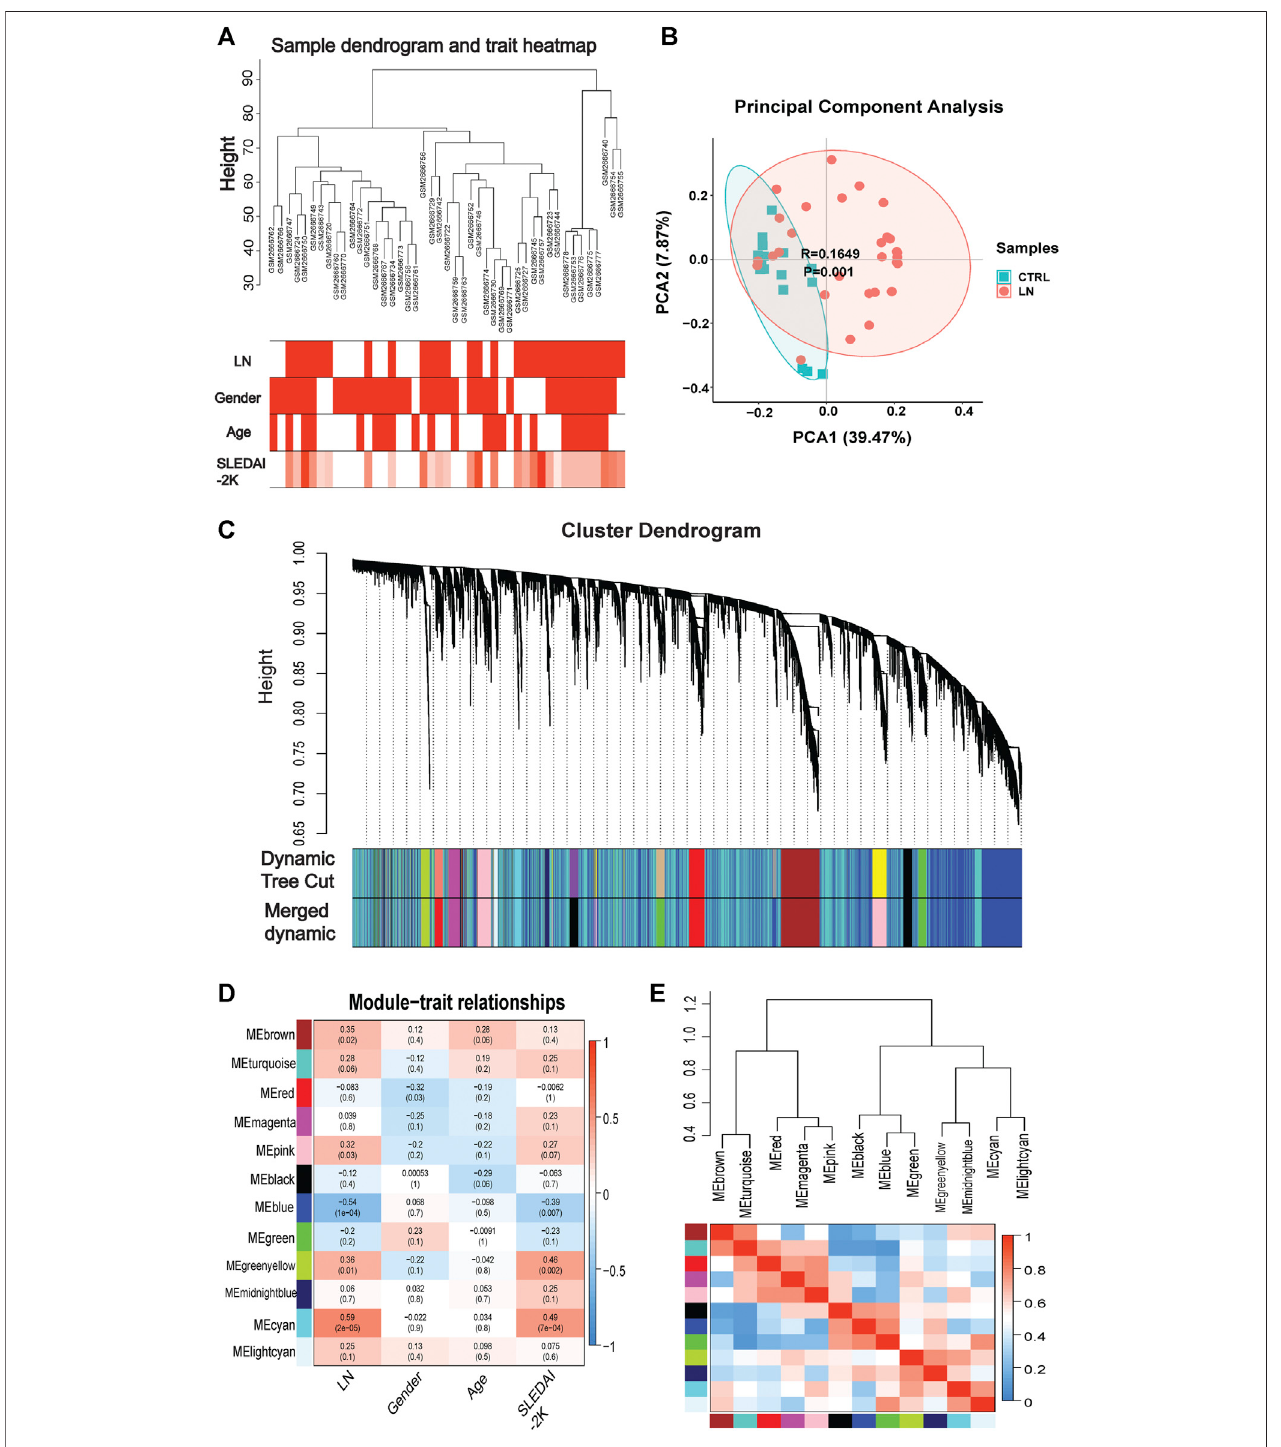
FIGURE 2 | | WGCNA analysis in GSE99968. (A) Sample-trait clustering heatmap. (B) Principal component analysis (PCA) shows the dimensionality reduction distribution of control and LN sets. (C) Dynamic shearing tree merging similar module genes. (D) Module-trait correlation heatmap. (E) Module-module clustering tree and correlation heatmap.